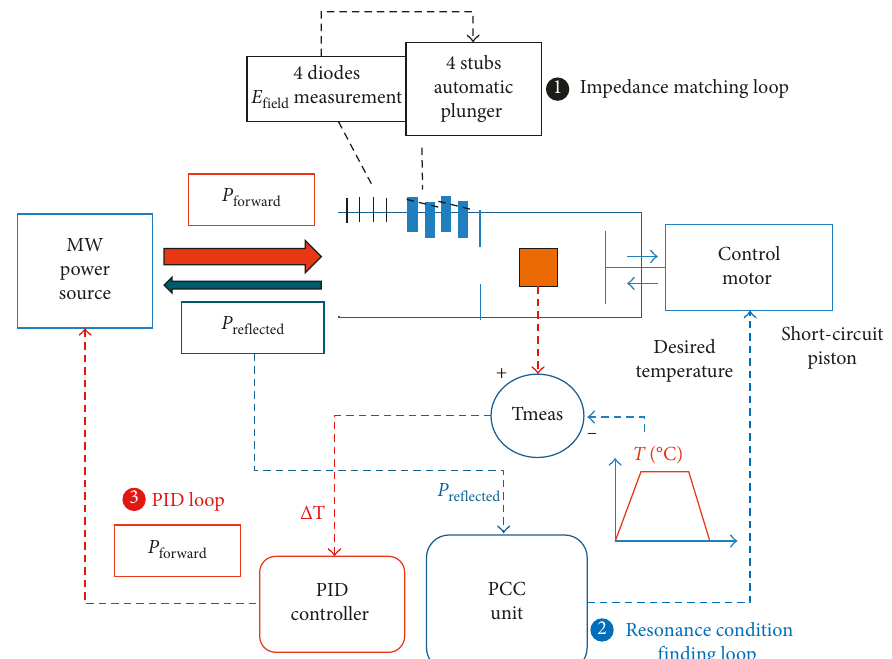
Figure 5: Block function diagram of the overall 915MHz microwave process designed to fully automatize the temperature regulation with resonance tuning and impedance